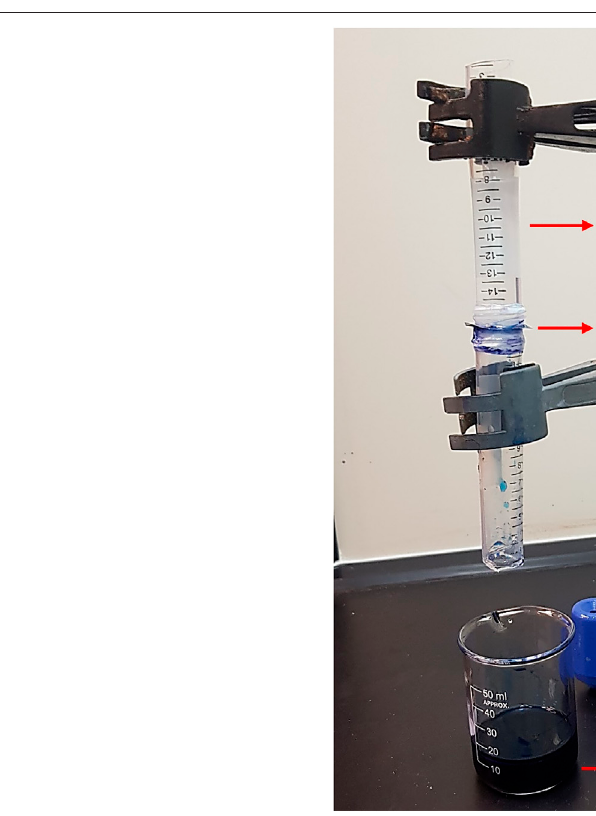
FIGURE 8 | Oil – water separation apparatus using the zeolite-coated laser-structured SS-100 meshes.